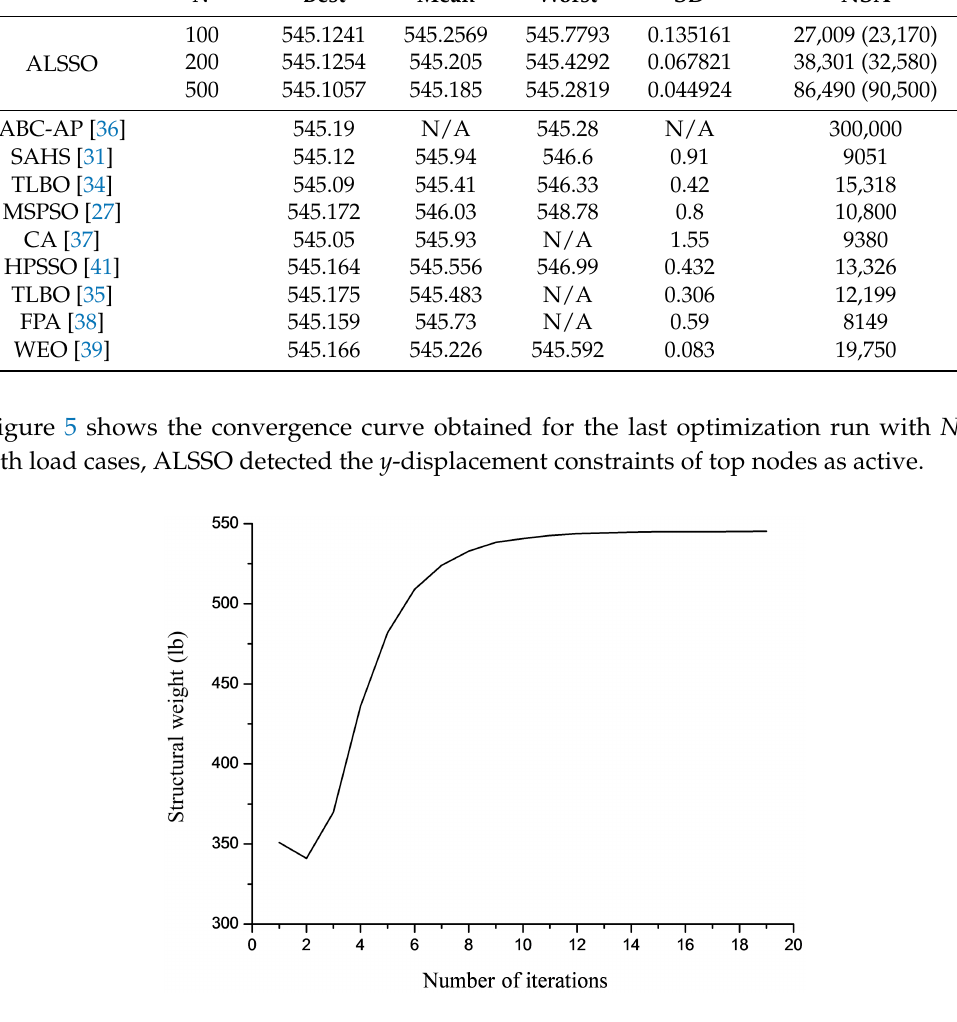
Figure 5 . Convergence curve obtained for the 25-bar truss problem with N = 500. Figure 5. Convergence curve obtained for the 25-bar truss problem with N =